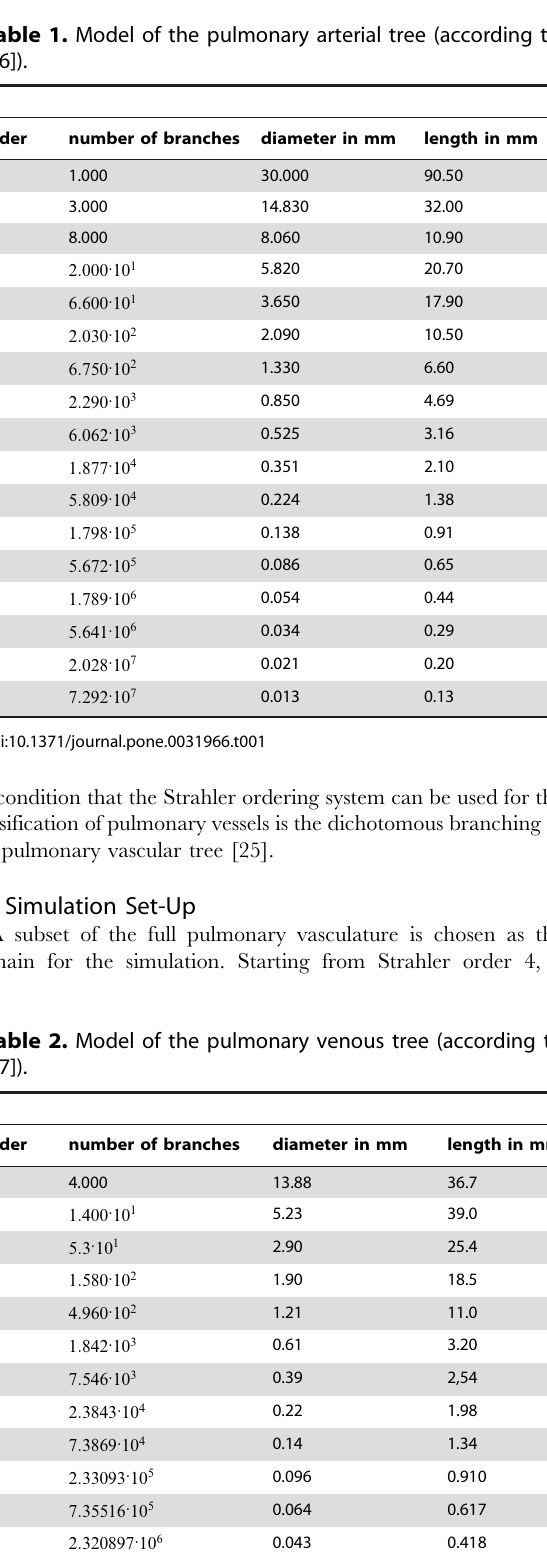
Table 1. Model of the pulmonary arterial tree (according to [36]).